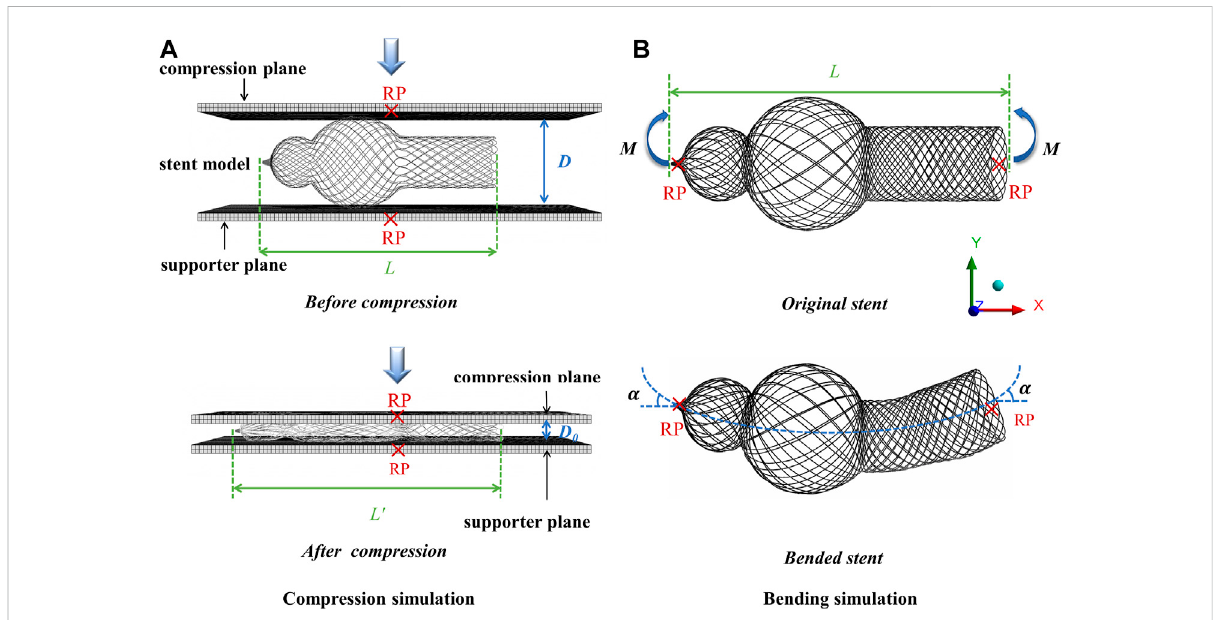
FIGURE 3 Schemes of the performed simulations. (A) Compression simulation. (B) Bending